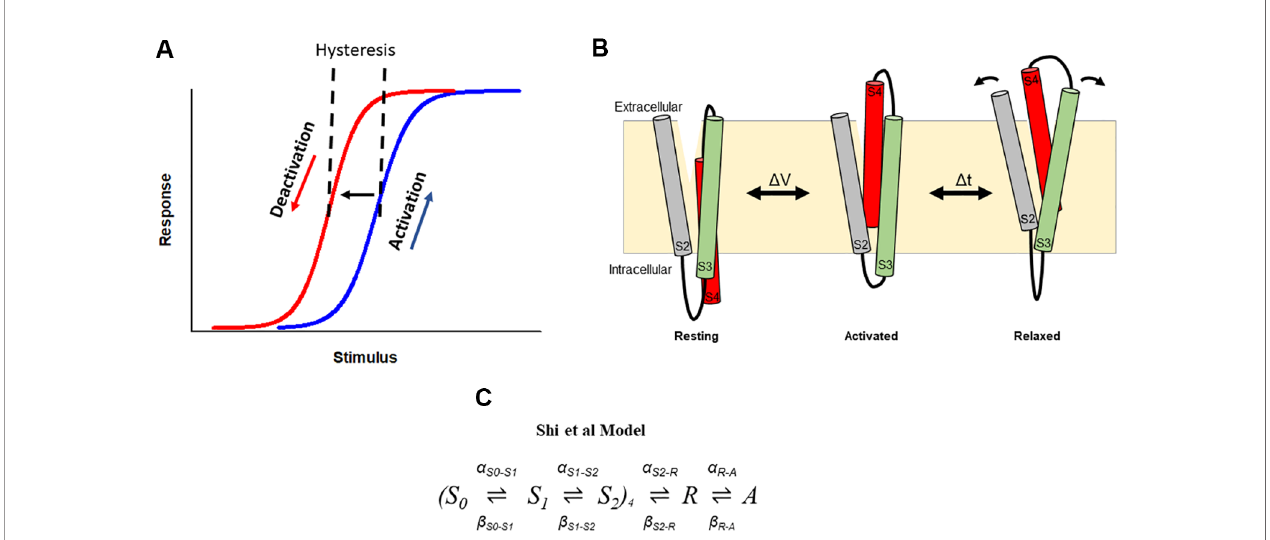
FIGURE 3 | Hysteresis in hERG channels due to voltage sensor relaxation. (A) In a hysteretic system, the response of the system differs in response to activating and deactivating stimuli. In hERG channels, depolarization activates (blue) channels, which then shift to a different mode (i.e., enter the relaxed state), from which deactivation follows a different response upon repolarization (red). This produces a hysteresis. (B) . Cartoon representation of stabilization the S4 voltage sensor into a relaxed conformation during voltage sensor relaxation. Arrows represent hypothetic reorganization of helices during relaxation as a result of interactions involving acidic residues in S2 – S3. (C) . The Shi et al. model of voltage sensor gating adopts the formulation of the Piper et al . gating charge model and includes addition of description of hysteresis behavior of the hERG channel voltage sensor as a result of voltage sensor relaxation (Shi et al.,